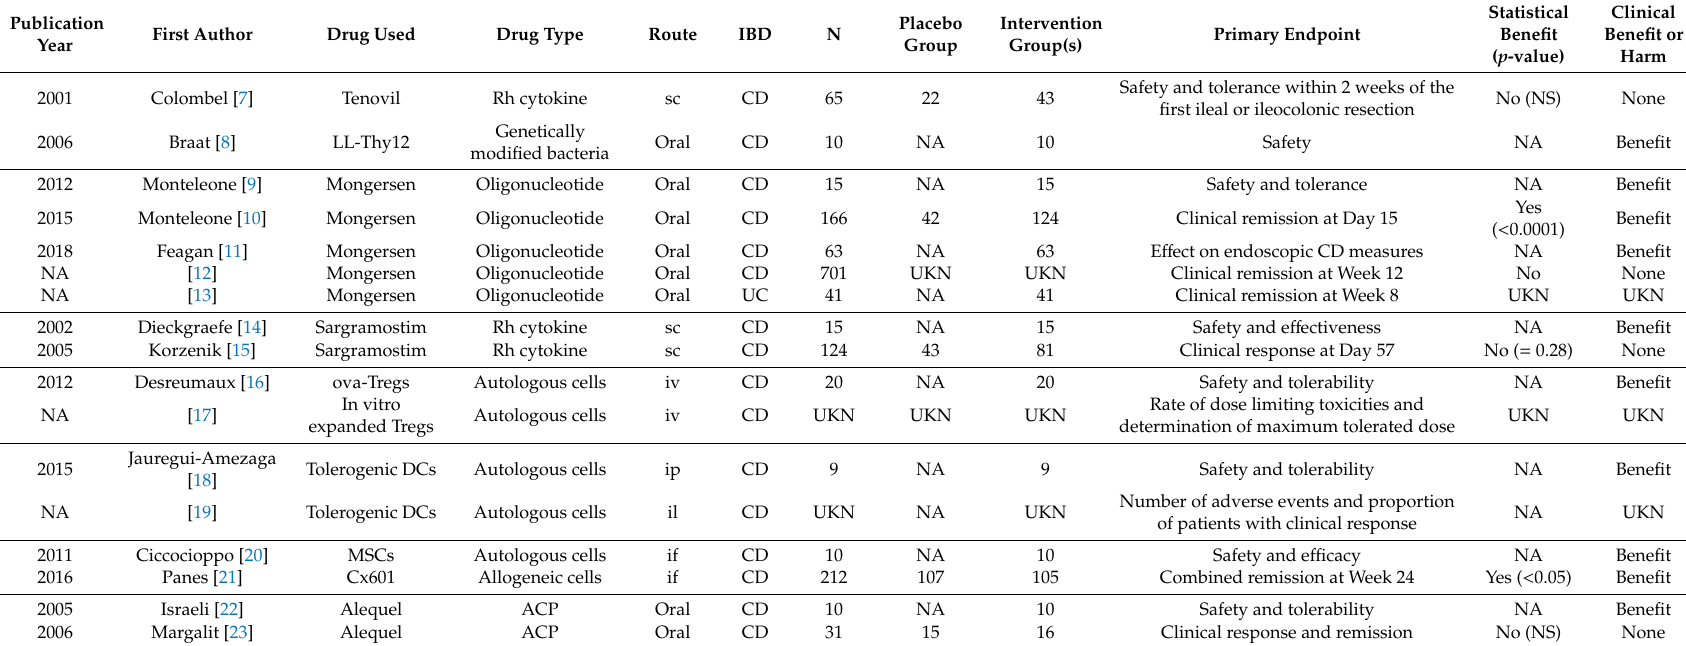
Table 1. Molecules restoring anti-inflammatory signals in inflammatory bowel